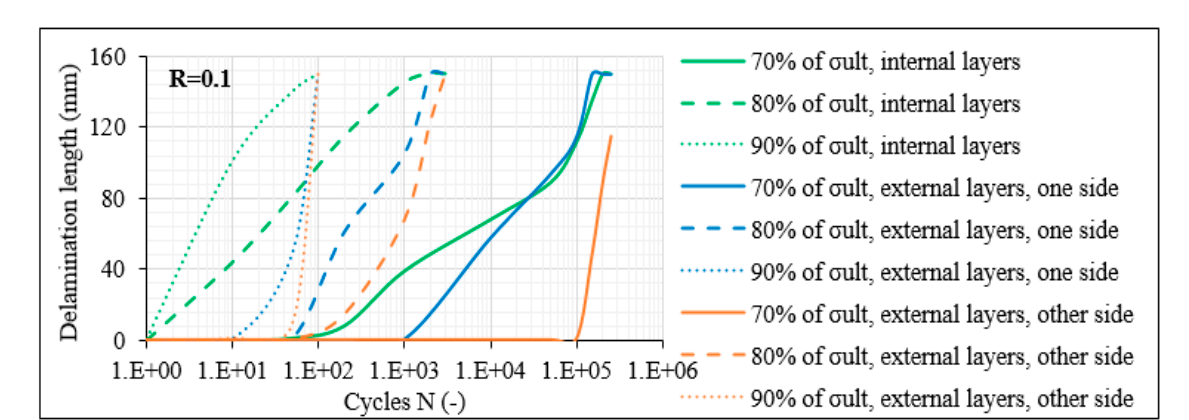
Figure 17. Delamination crack growth versus N in [0°/30°/0°/ − 30°] s laminates for R = 0.1.